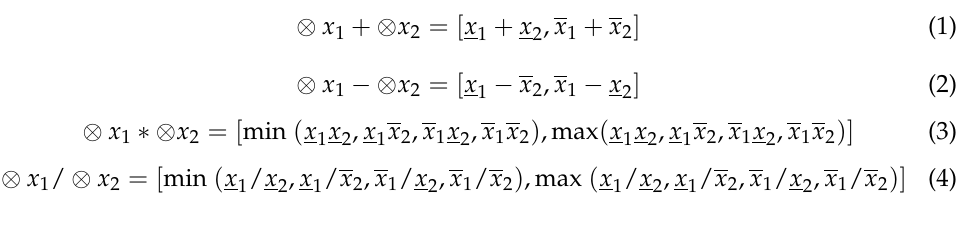
, x 1 ] and ⊗ x 2 = [ x , x 2 ] 1 2